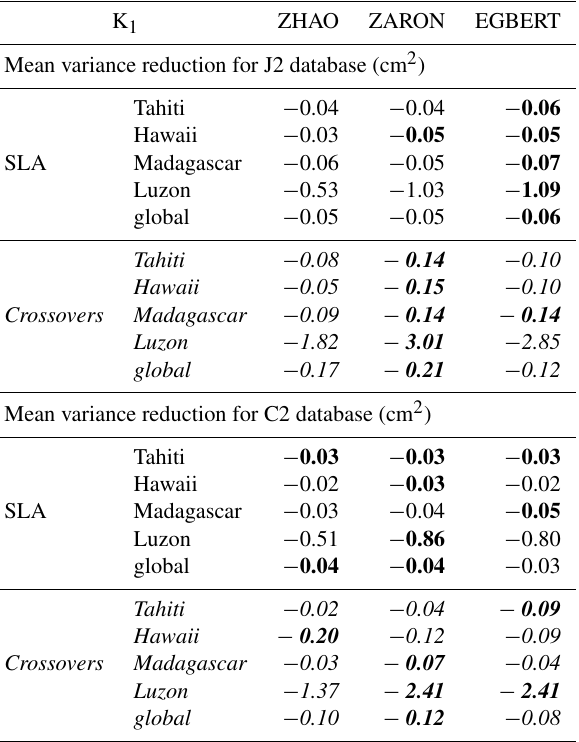
Table 5. Mean variance reduction for J2 and C2 altimeter databases, within each IT region, when using the different K 1 internal-tide models and compared to the ZERO correction case; variance re- duction in altimeter SLA (white lines) and for altimeter crossover differences (italic lines) for each mission, in square centimeters. For each IT region, the maximum variance reduction across the differ- ent models is highlighted in